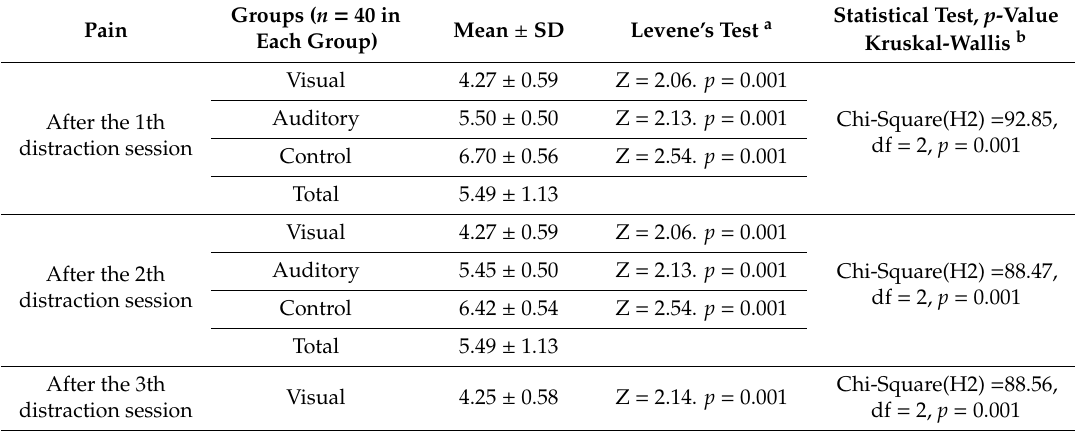
Table 2. Comparison of pain in the groups.